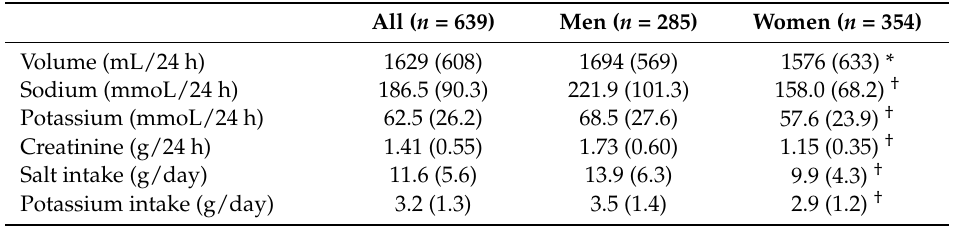
Table 2. Daily urinary excretions of volume, sodium, potassium and creatinine and estimates of salt and potassium intake. All ( n =